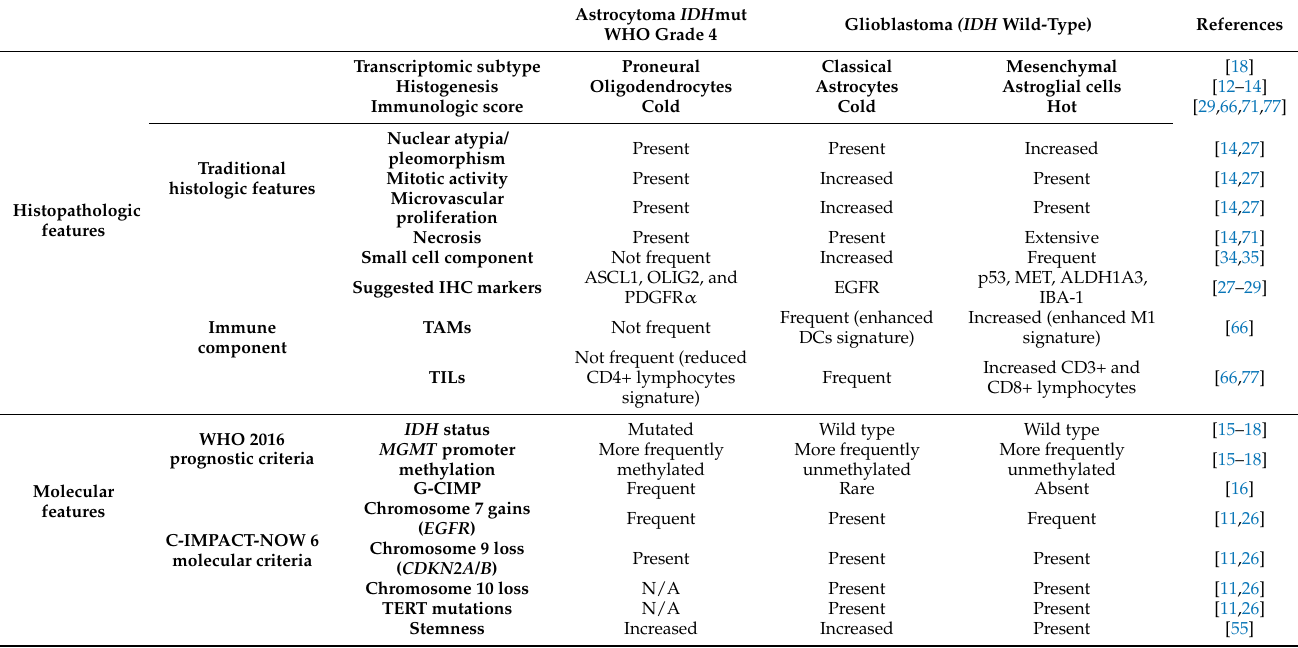
Table 1. Summary of the histopathological, immunohistochemical, and molecular features of Grade 4 IDH -mutant gliomas and